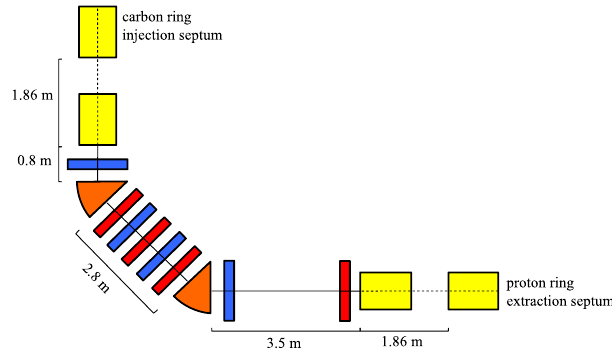
the proton to the carbon ring. Vertical bends are shown with dashed lines, yellow magnets bend in the vertical plane, orange dipoles bend in the horizontal plane, red rectangles are focusing quadrupoles (in the horizontal plane), and blue rectangles are defocusing.